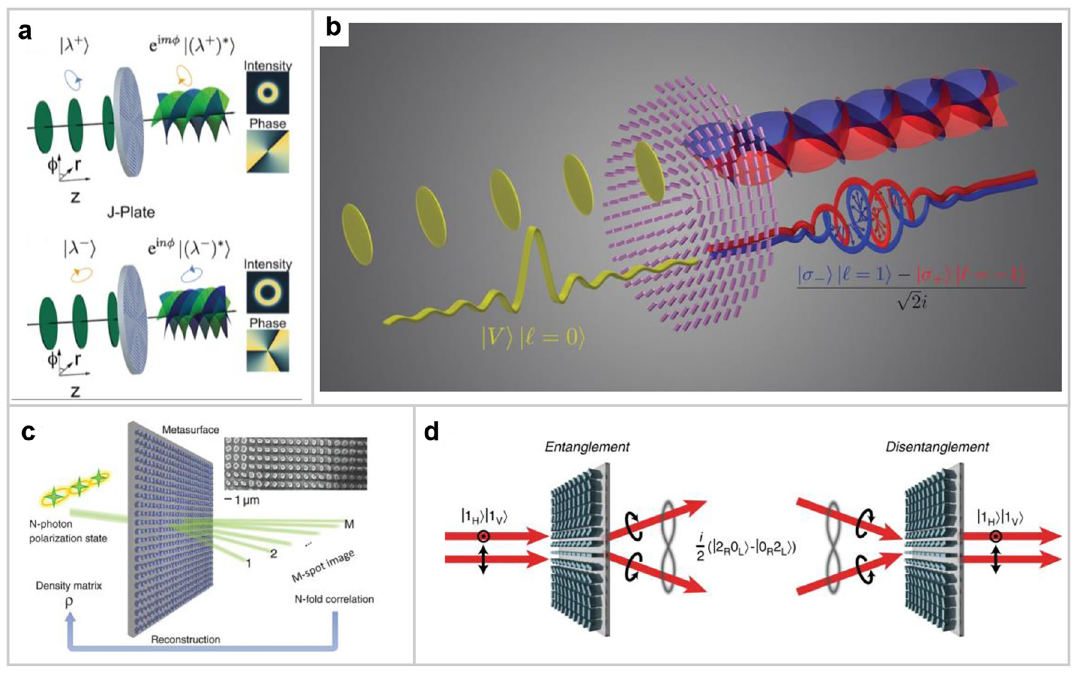
Figure 11: Applications of in quantum optics with all-dielectric metasurfaces. (a) Schematic of the left and right circularly polarized light converted into vortex light [145]. (b) Schematic of metasurface to form entanglement between spin and OAM on a single photon, yellow plane represents plane wavefront, red and blue represent opposite vortex phase wavefront [148]. (c) The schematic of metasurface which can make N-photonimageatM-spot.Insertionisascanningelectronmicroscopyimageofall-dielectricmetasurface[149].(d)Schematicofmetasurface that used to generate entanglement and disentanglement of two photons state. Entanglelment: two photons with orthogonoal linear po- larization state are divided into circular polarization components in the same channel (left). Disentangle: The inverse of the above process (right) [150]. Reprint permission obtained from [145, 148 –